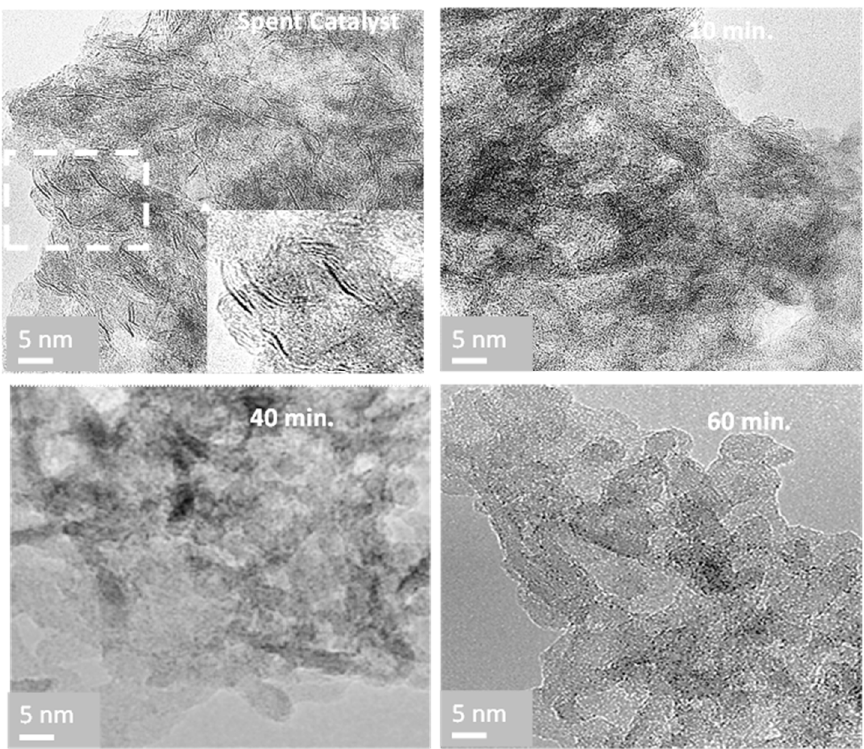
Figure 3. TEM images of the spent catalyst before and after NTP treatment were carried out at 7 W at 200 °C during 10, 40, and 60 min.